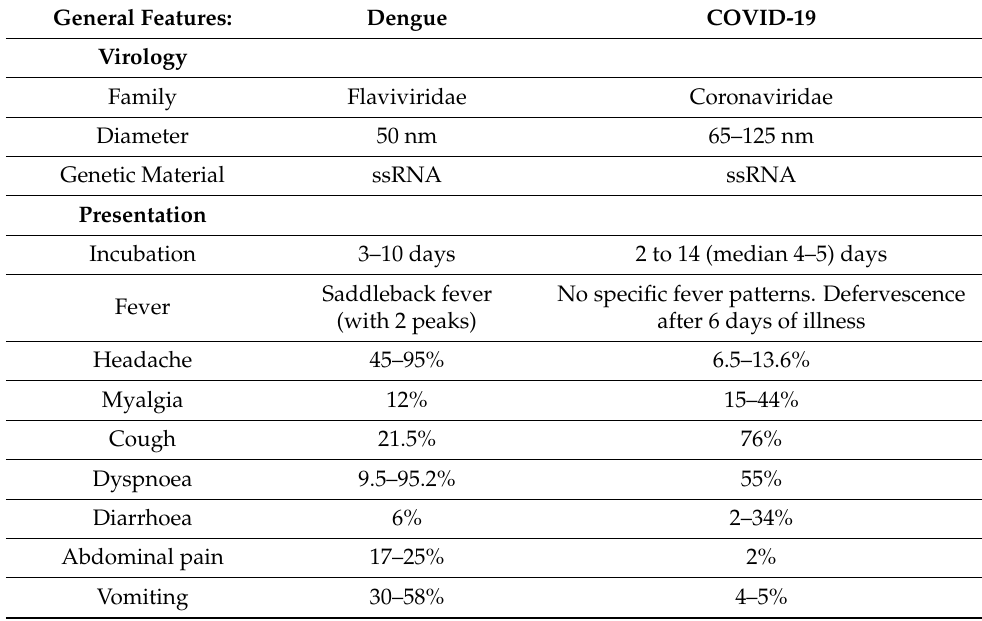
Table 1. Comparing dengue and COVID-19, based on data from Henrina et al. [7] and Centers for Disease Control and Prevention guidance